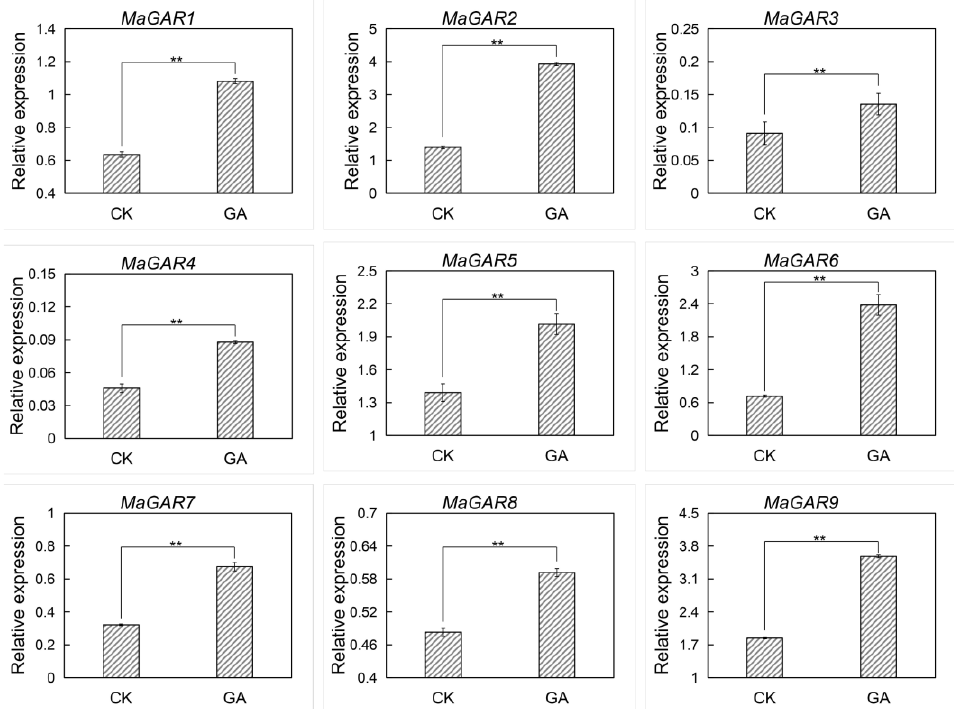
Figure 7. Expression levels of candidate genes after GA3 treatment using qRT-PCR. Data were means of three biological repetitions. Each bar represents mean ± SE, and asterisks (**) indicate significant differences (Student ’ s t -test, p < 0.01).